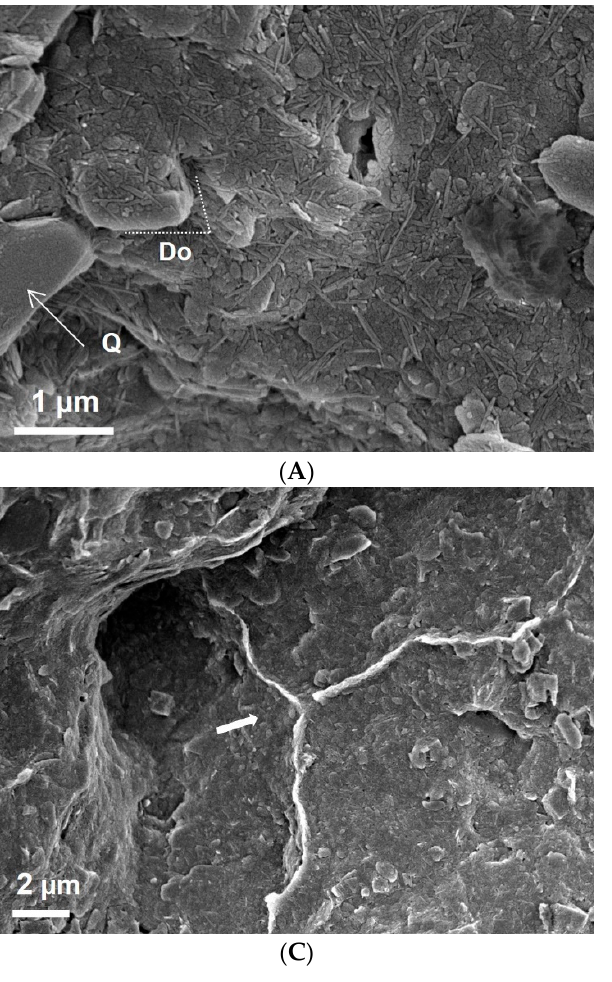
Figure 5. Scanning electron micrographs of the clay levels. ( A ) General view of the massive and laminar texture of the clayey levels, with coarse quartz grains (Q), some dolomitic rhombic crystals (Do), and palygorskite fibers. ( B ) Stacked clays with domains defined by overlapping face-to-face contacts. ( C ) Triple point structures originated by the orientation of clay minerals normal to the bedding plane. ( D ) Detail of the triple point